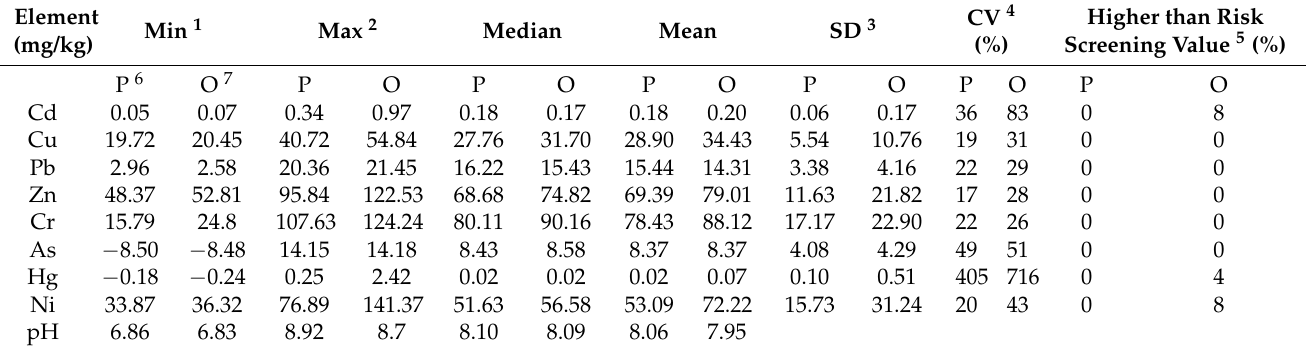
Table 1. Concentrations of eight heavy metals in soils planted with potato and hulless